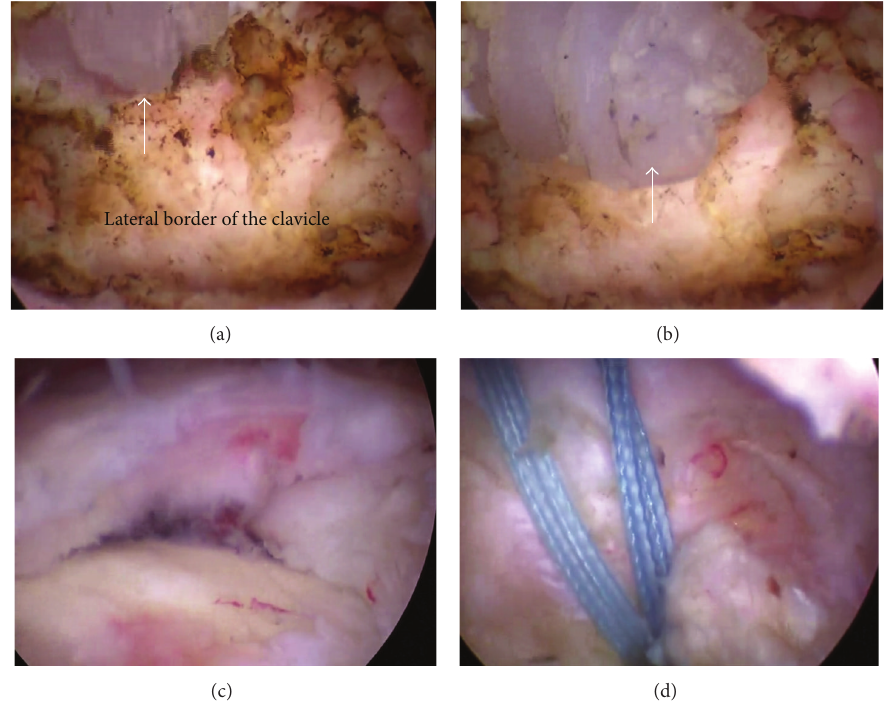
Figure 2: Arthroscopic images confirmed the MRI findings. (a) View through the posterior portal: it is able to see the bioabsorbable anchor in the ACJ (white arrow). We used a spinal needle inserted through the skin superiorly through the ACJ joint, to push the anchor down ((b) white arrow) and retrieve it from the lateral working portal. (c) The retear of the rotator cuff was repaired with double row technique (d) using 2 medial and 1 lateral bioabsorbable